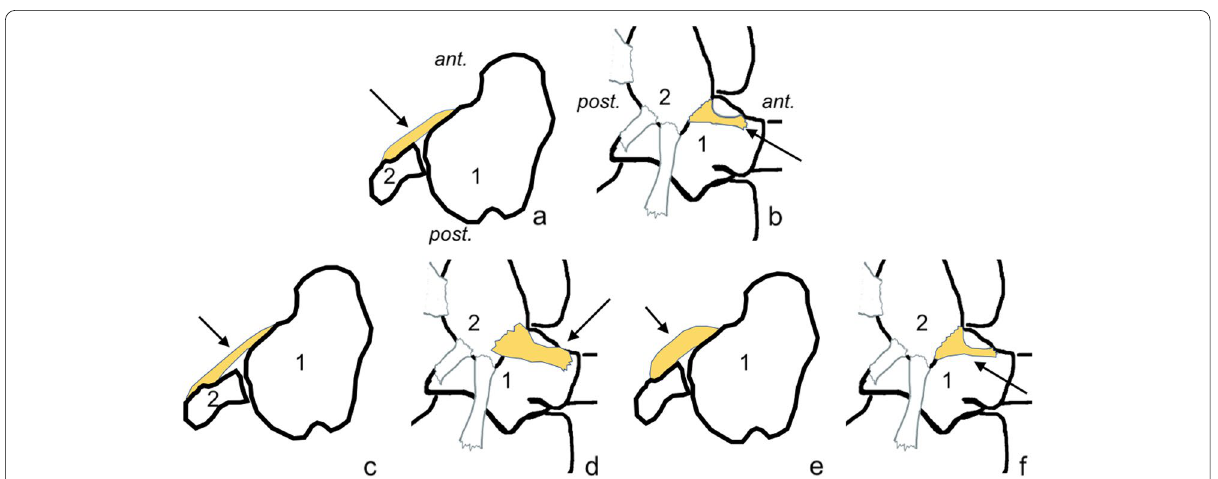
Fig. 6 Examples of correlations between the dimensions of the anterior talofibular ligament. A , c , and e transverse section; b , d , and f view from the lateral side. Ant., anterior; post., posterior; 1, talus; 2, fibula. C and d the increased length of the anterior talofibular ligament is positively correlated with width and negatively correlated with thickness. E and f the increased thickness of the ATFL is positively correlated with the length of the fibular insertion and negatively correlated with the width and length of the talar insertion, and there is a very weak positive correlation with